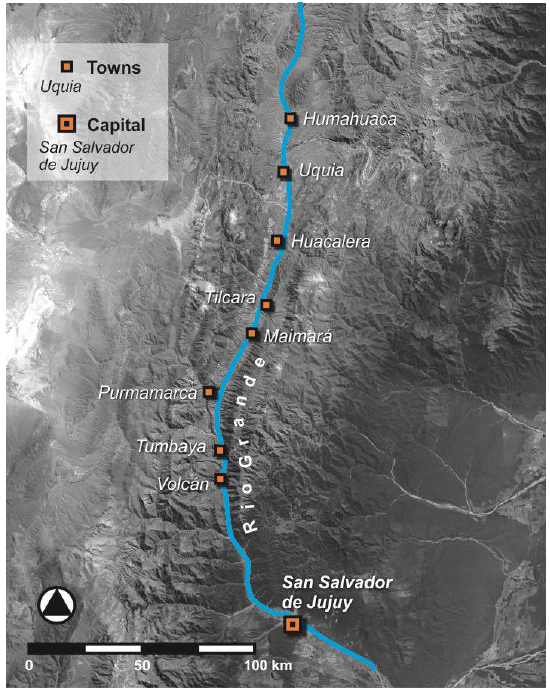
Figure 2. Quebrada de Humahuaca with some of its main towns ©